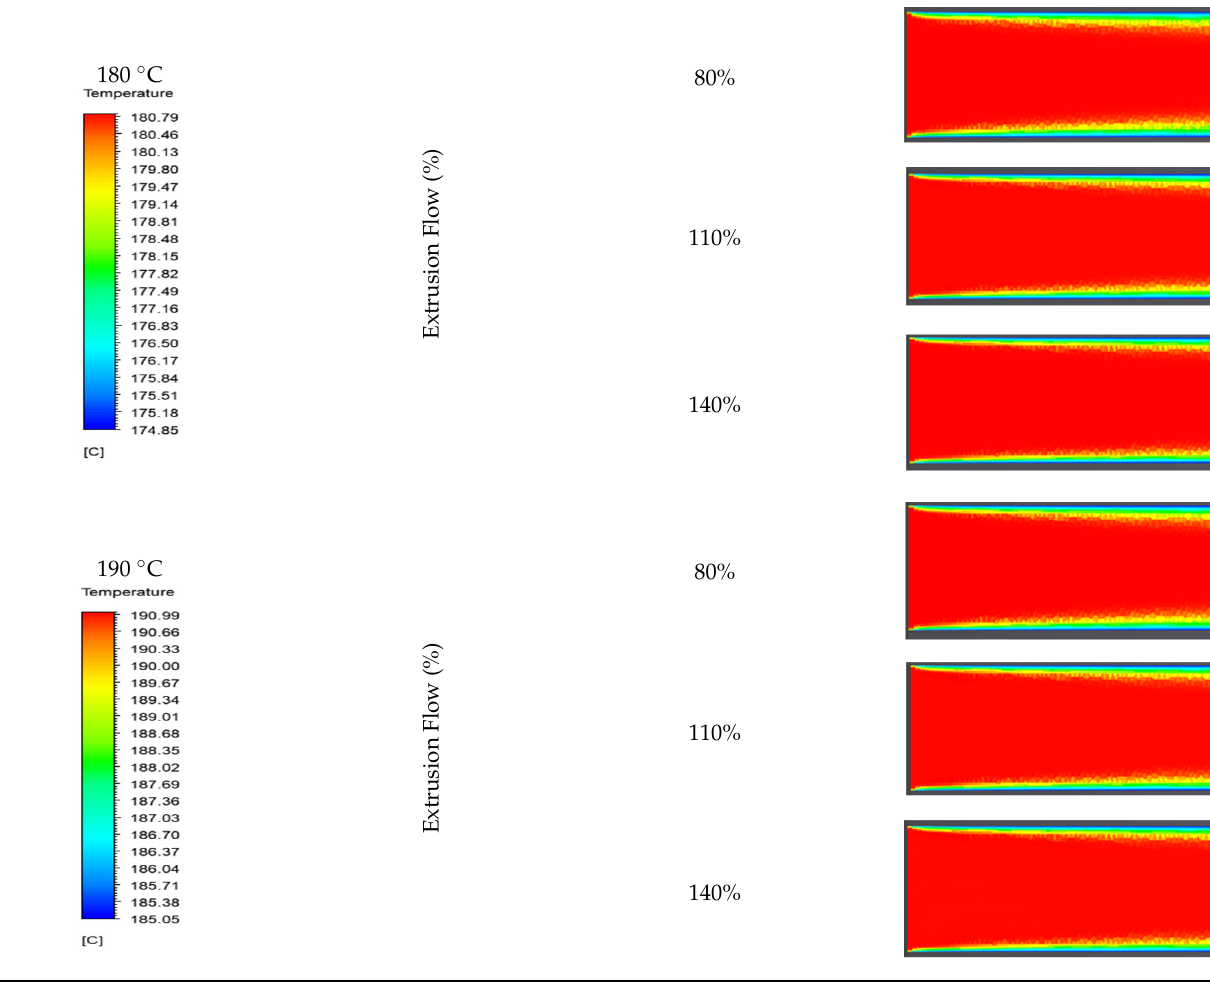
Table 8. ROM results for nozzle microchannel temperature profiles.